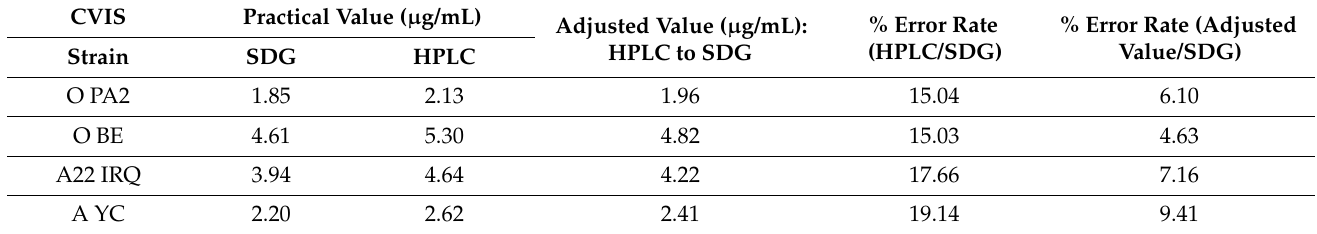
Table 2. Adjusting the 146S antigen value of SE-HPLC to that of SDG using the BEV standard: applied to a crude virus infection supernatant